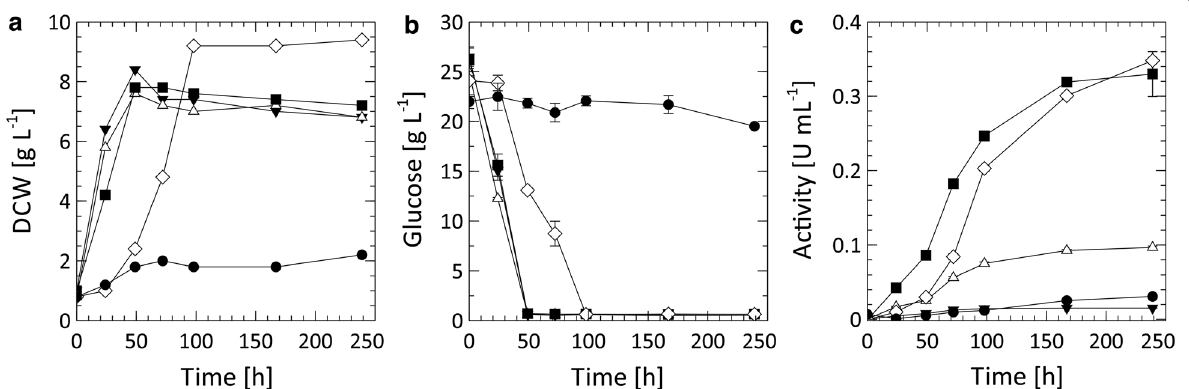
Fig. 3 Effect of cultivation temperature on DCW ( a ), glucose concentration ( b ), and laccase activity ( c ). Strain A. adeninivorans G1212/ YRC102-TEF1-TVLCC5-6H was grown at 10 °C (black circle), 20 °C (white diamond), 30 °C (black square), 37 °C (white up-pointing triangle), and 42 °C (black down-pointing